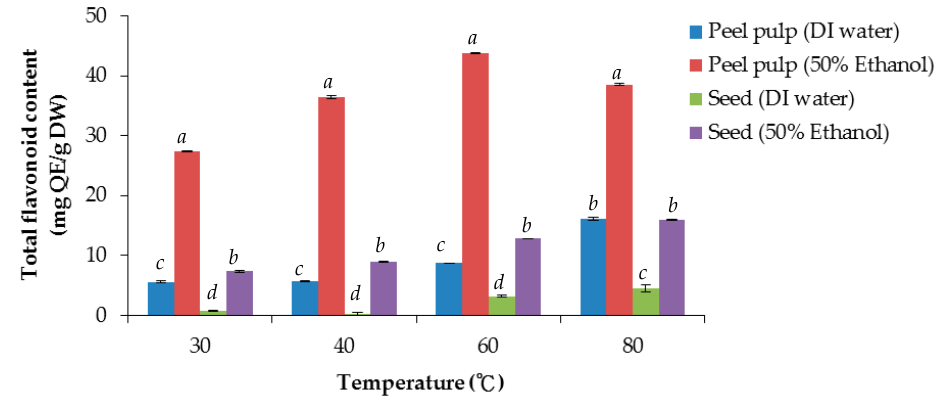
Figure 6. Total flavonoid content of jujube peel pulp and seeds extracted with DI water and 50% ethanol at di ff erent temperatures. The error bar represents the standard error of the mean. The temperatures in the histogram with the same letter were not significantly di ff erent at the 5% level, according to the results of the LSD